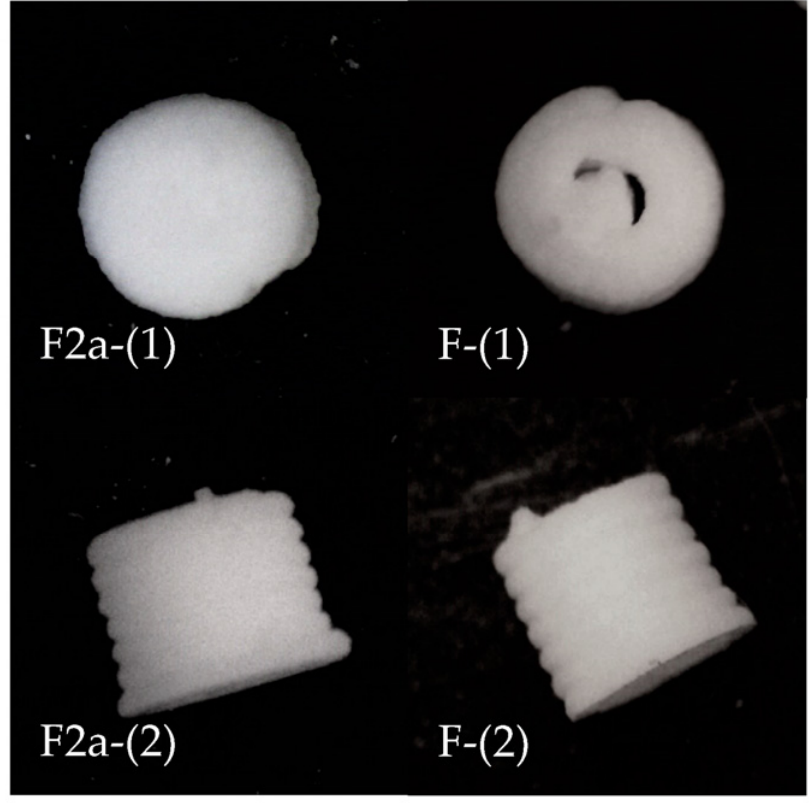
Figure 7. Appearance of F2a compared with F ODMTs (post-drying for 24 h); F2a-(1), F-(1): top view; F2a-(2), F-(2): side view.